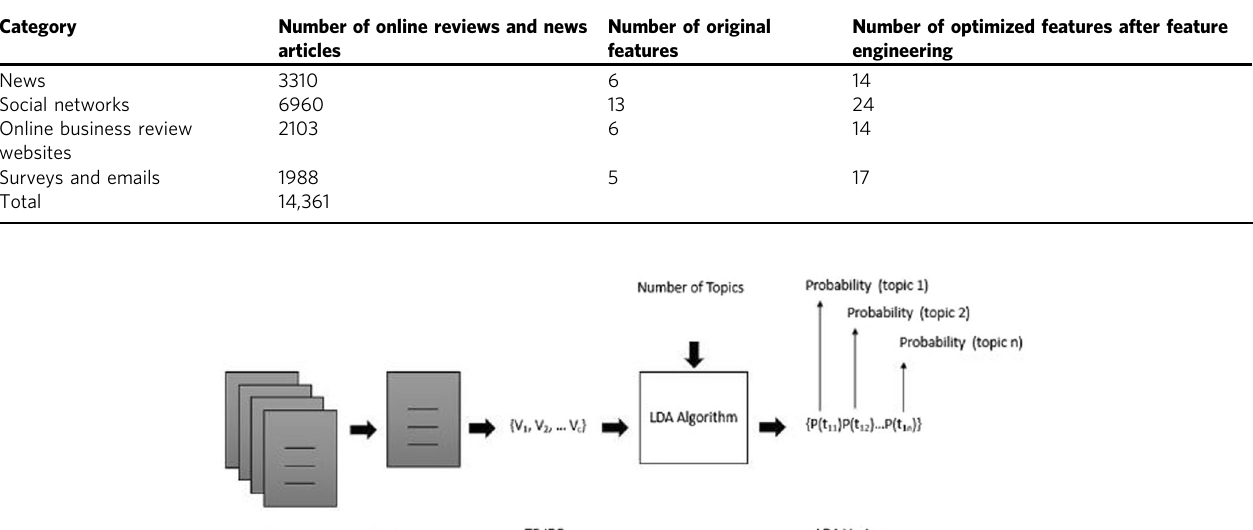
Table 1 Statistics information about the dataset includes the number of original features in each category of data source, as well as the number of optimal features after feature engineering.